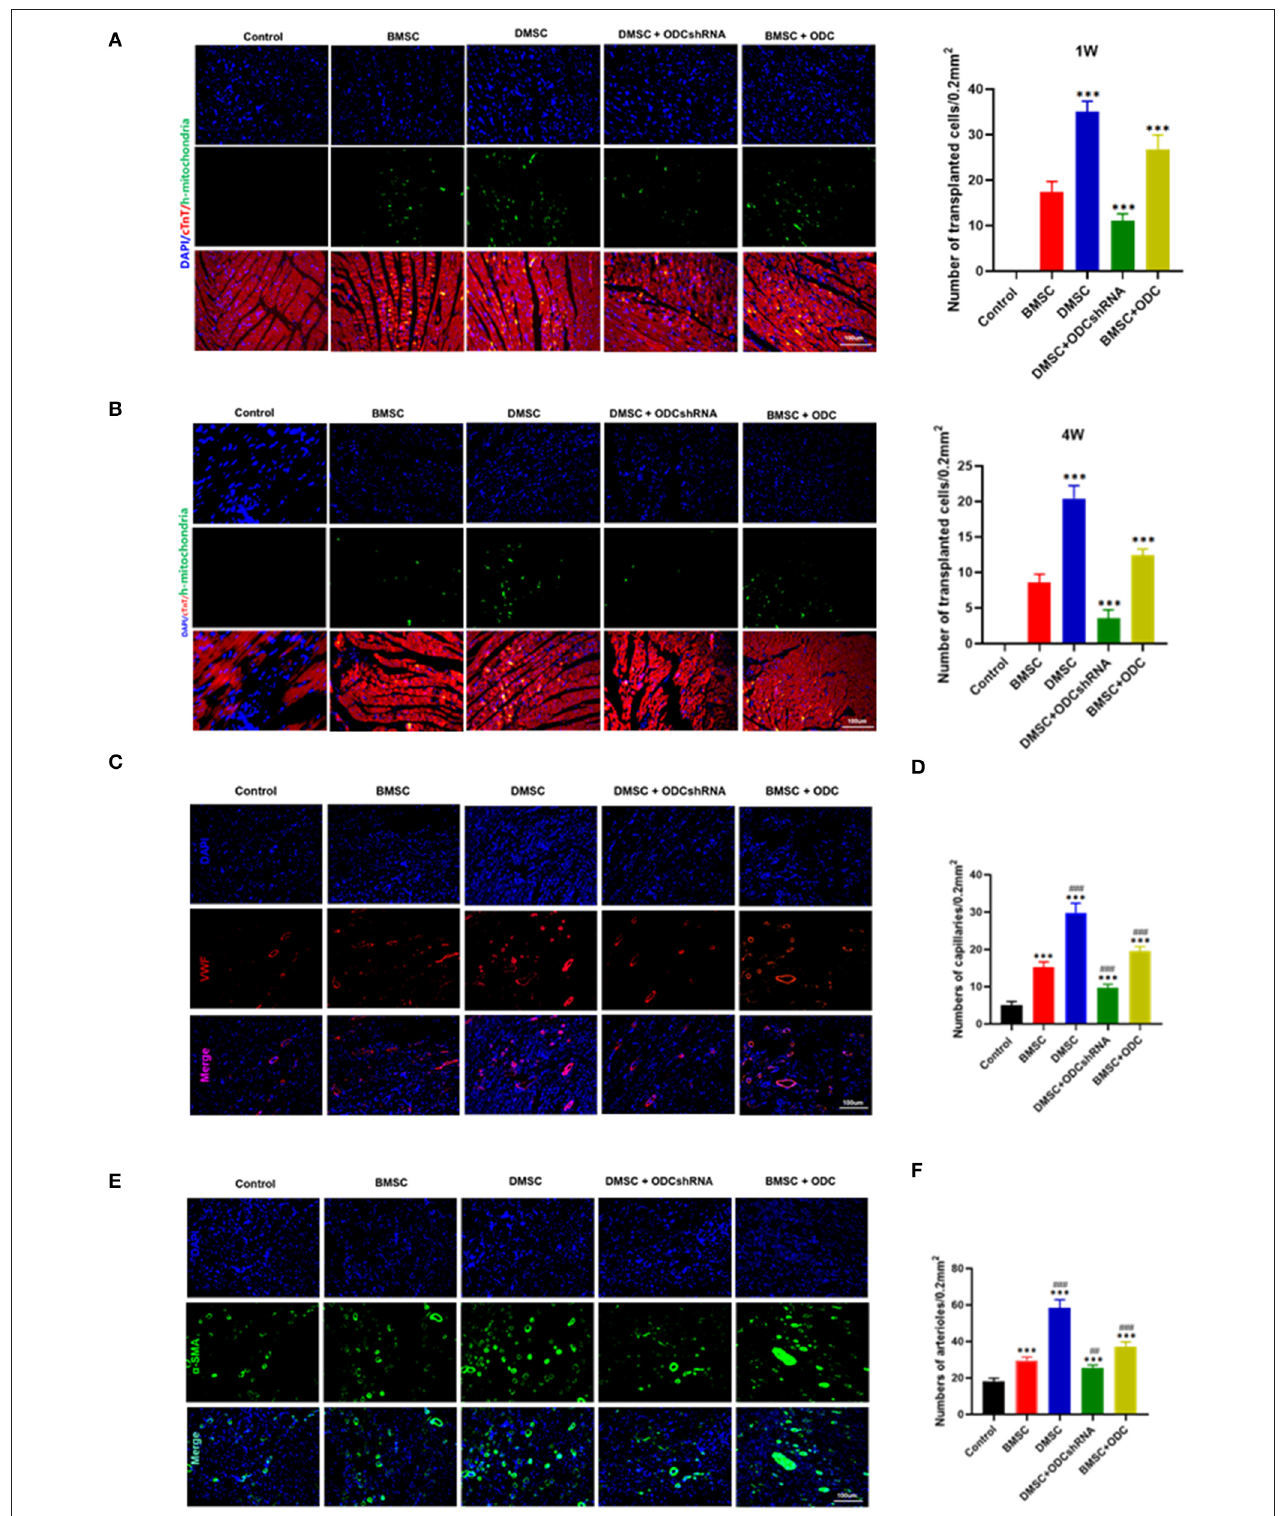
FIGURE 4 | ODC inhibition partly abolished the effects of DMSCs on angiogenesis in vivo . (A,B) Anti-human mitochondrial staining showed the survival of transplanted cells for 1 and 4 weeks in vivo . (C–F) Blood vessel density determined by a-SMA and VWF staining for 4 weeks in vivo . *** P < 0.001, # P < 0.05, ## P < 0.01, ### P <